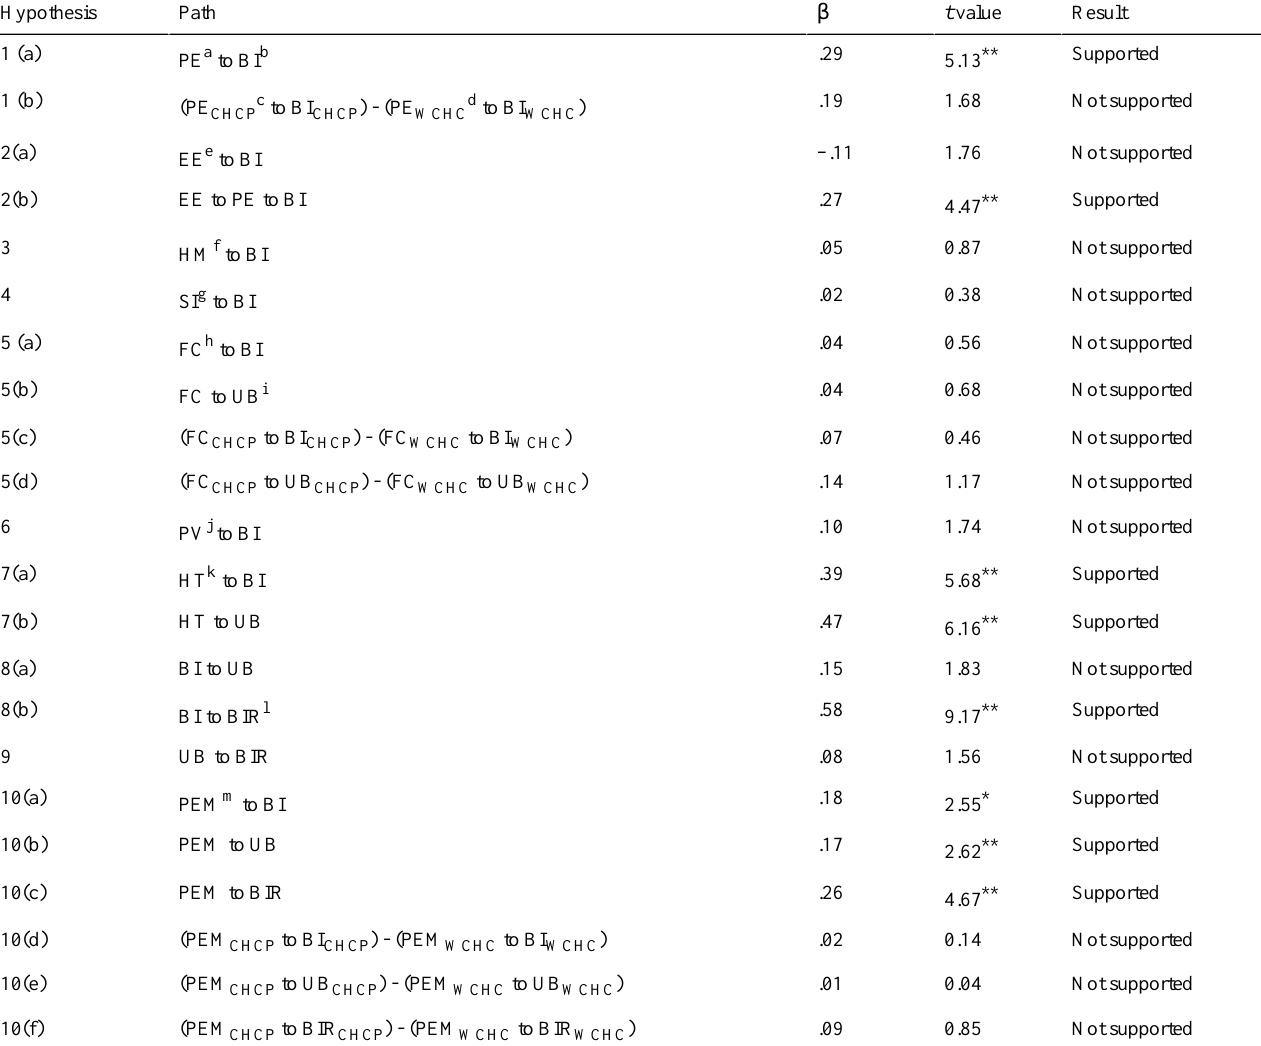
Table 8. Summary of findings regarding the